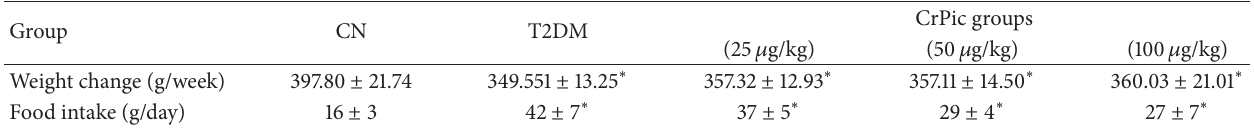
Table 3: The weight change and food intake of the rats in each group during the whole experiment. Group CN T2DM